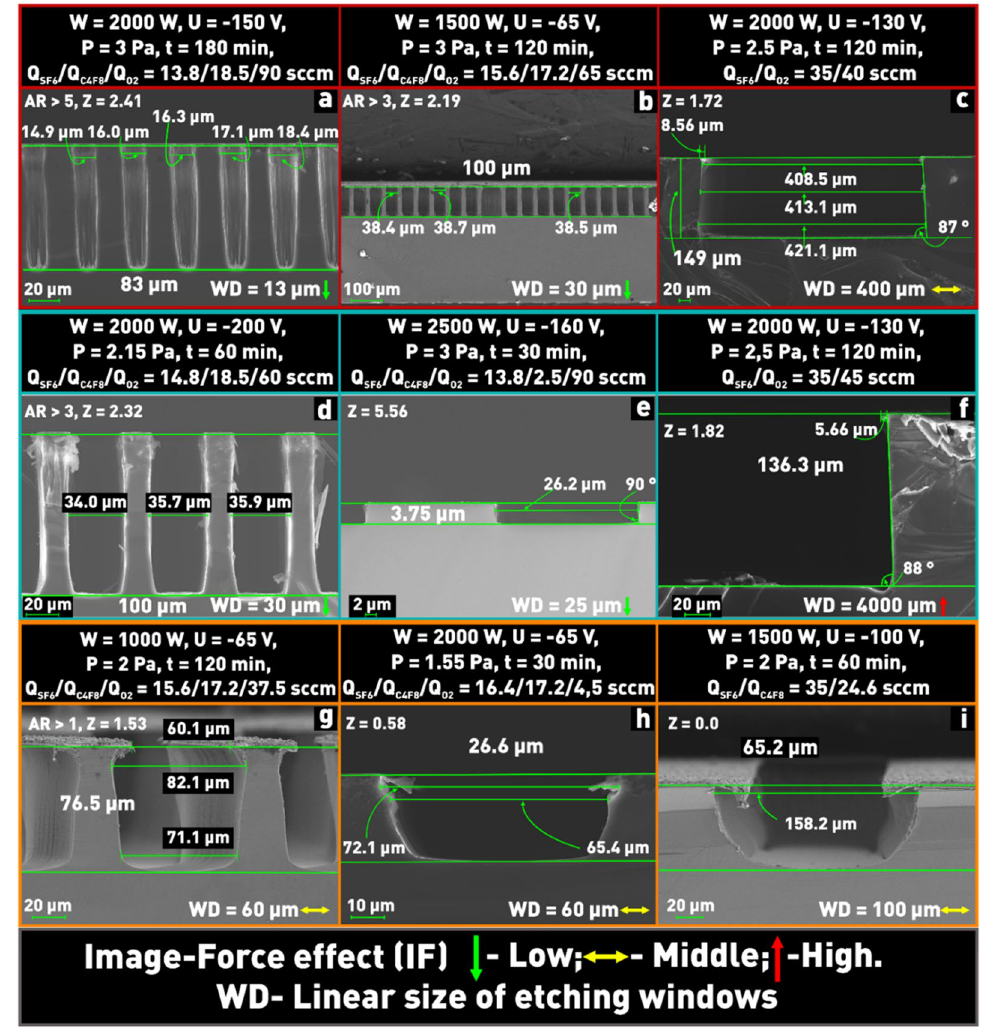
Figure 12. Microphotographs of etched window profiles at different values of process